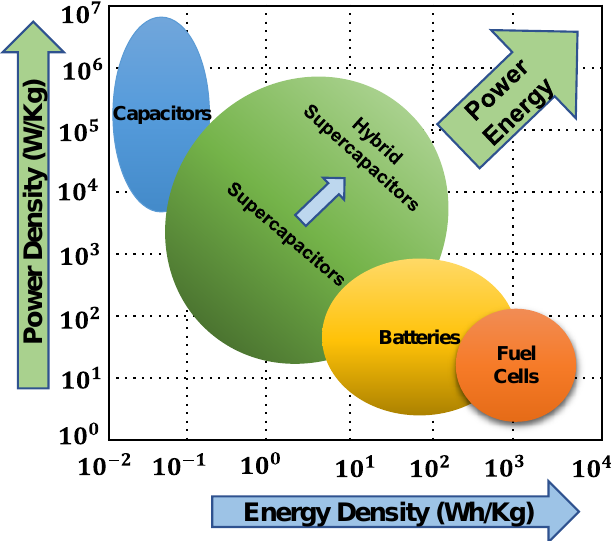
Figure 1. Ragone plot of the power–energy density range for various electrochemical energy storage devices.